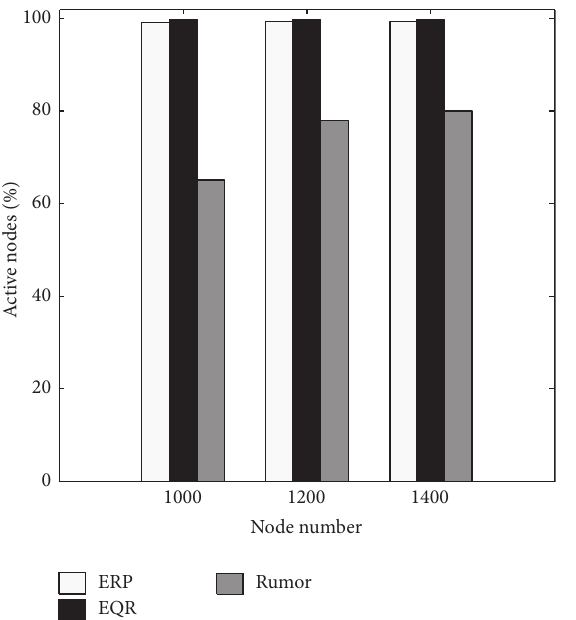
Figure 7: Test 4: average energy